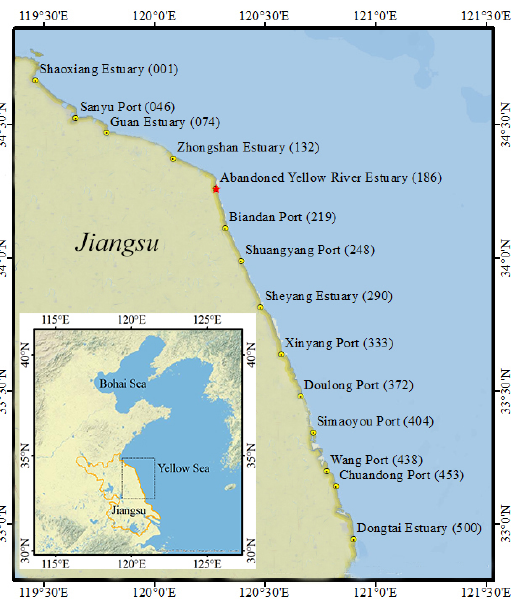
Figure 1. Study area and division of coast transect. The number in brackets is the transect number for main estuaries.